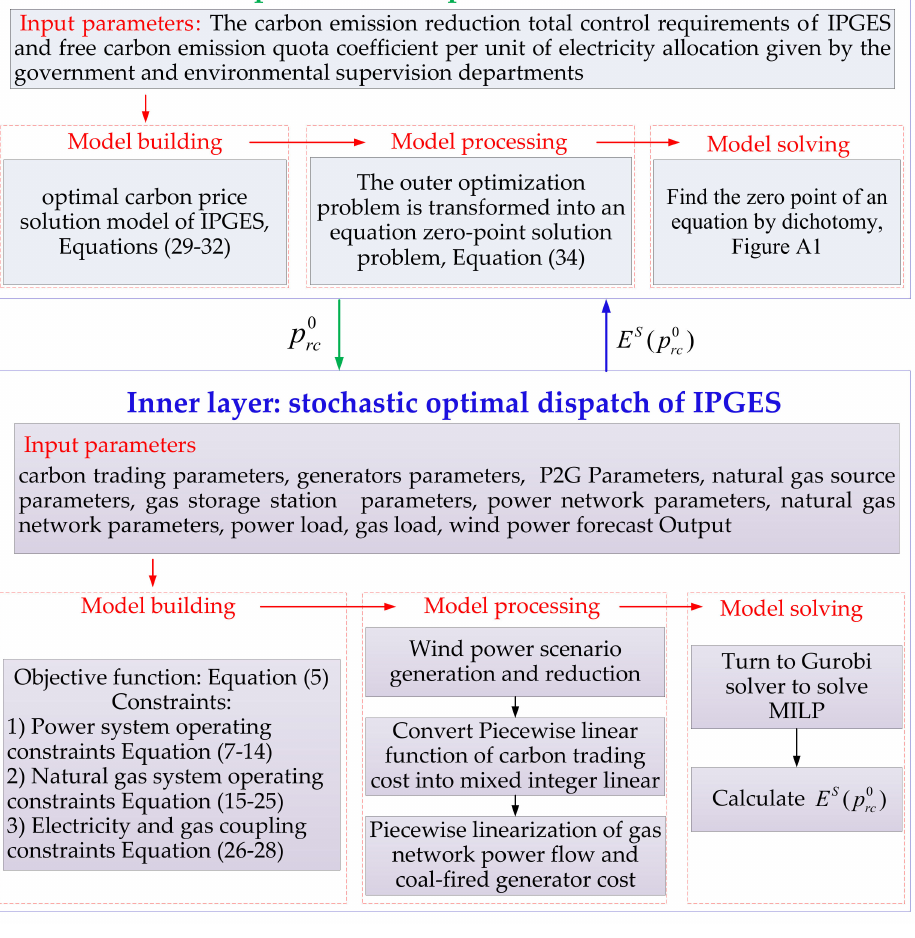
Figure 5. The flow chart of solving the bi-layer optimization